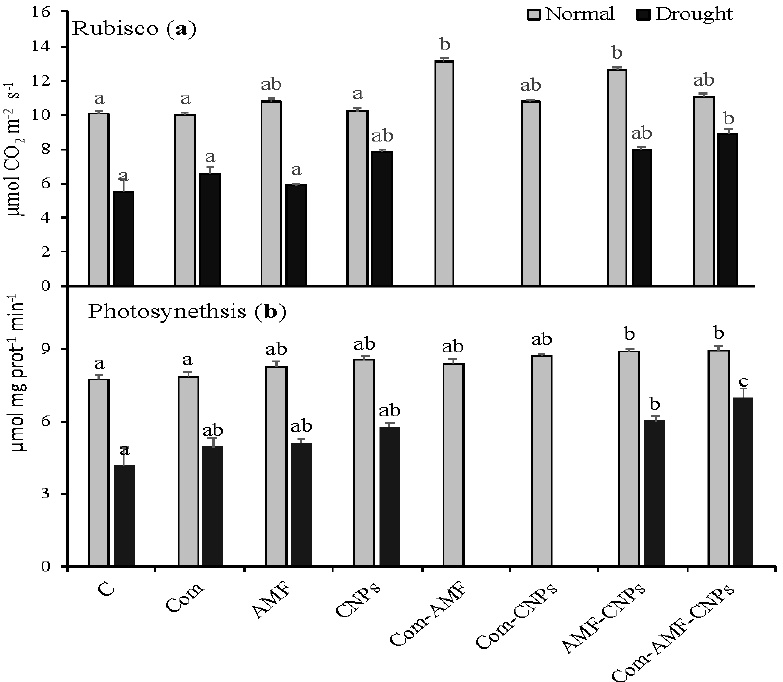
Figure 2. Effect of different treatments on the activity of ribulose-1,5-bisphosphate carboxylase-oxygenase ( a ) and photosynthesis ( b ) of maize under control and drought (D) conditions. Different letters indicate statistically significant difference between means for the different treatments at significance level of at least p ≤ 0.05. C: control, Com: compost, AMF: mycorrhiza, CNPs: carbon nanoparticles, D: drought.